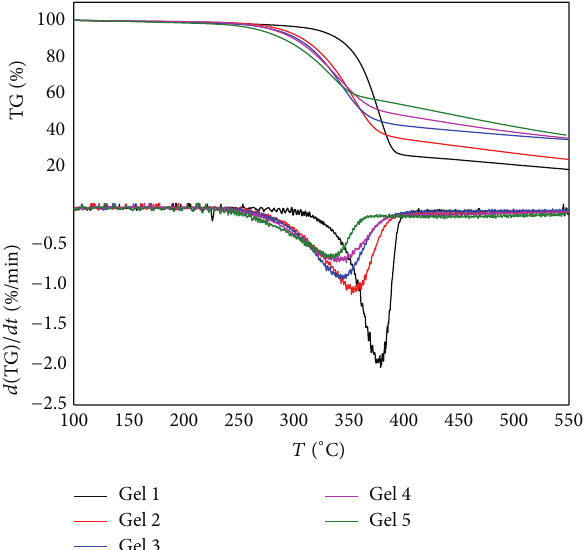
Figure 6: TG and DTG curves of the cellulose/MWCNTs hydrogels Gels 1–5.